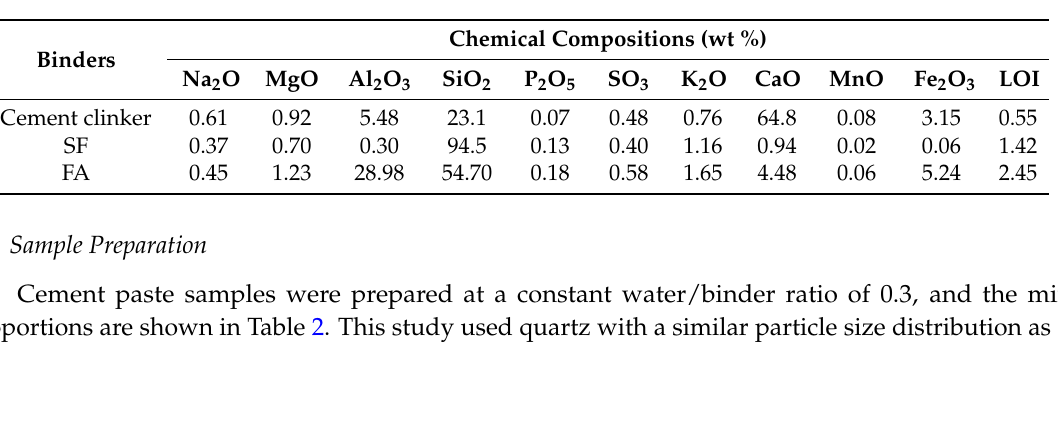
Table 1. Chemical compositions of